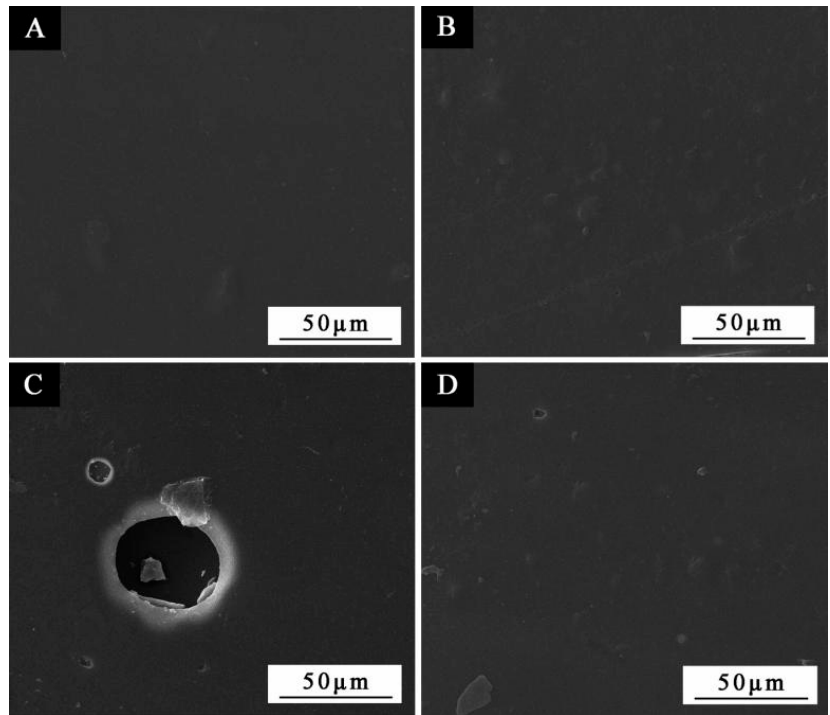
Figure 12. SEM of the paint film with and without microcapsules before and after aging in the 120 °C oven: before aging ( A ) without, ( B ) with microcapsules; after aging ( C ) without, ( D ) with microcapsules.